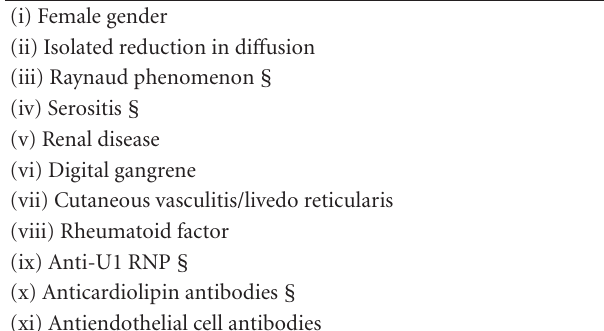
Table 4: Possible risk factors for the development of PH in systemic lupus